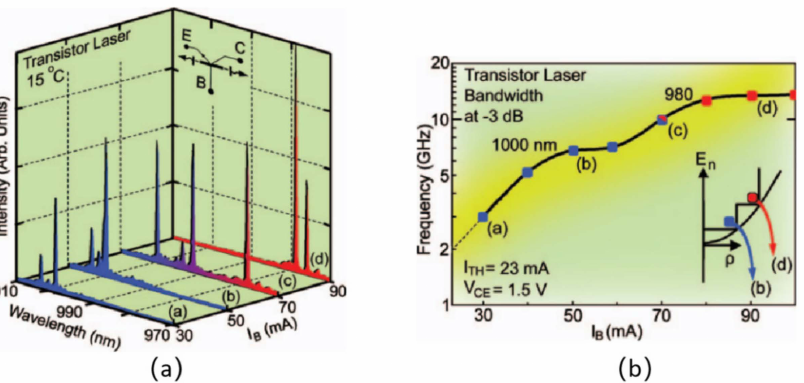
Figure 6. ( a ) Radiative recombination spectrum of I B and wavelength. ( b ) Curve of TL bandwidth under different currents, ground state energy level (blue), and first excited state energy level (red)